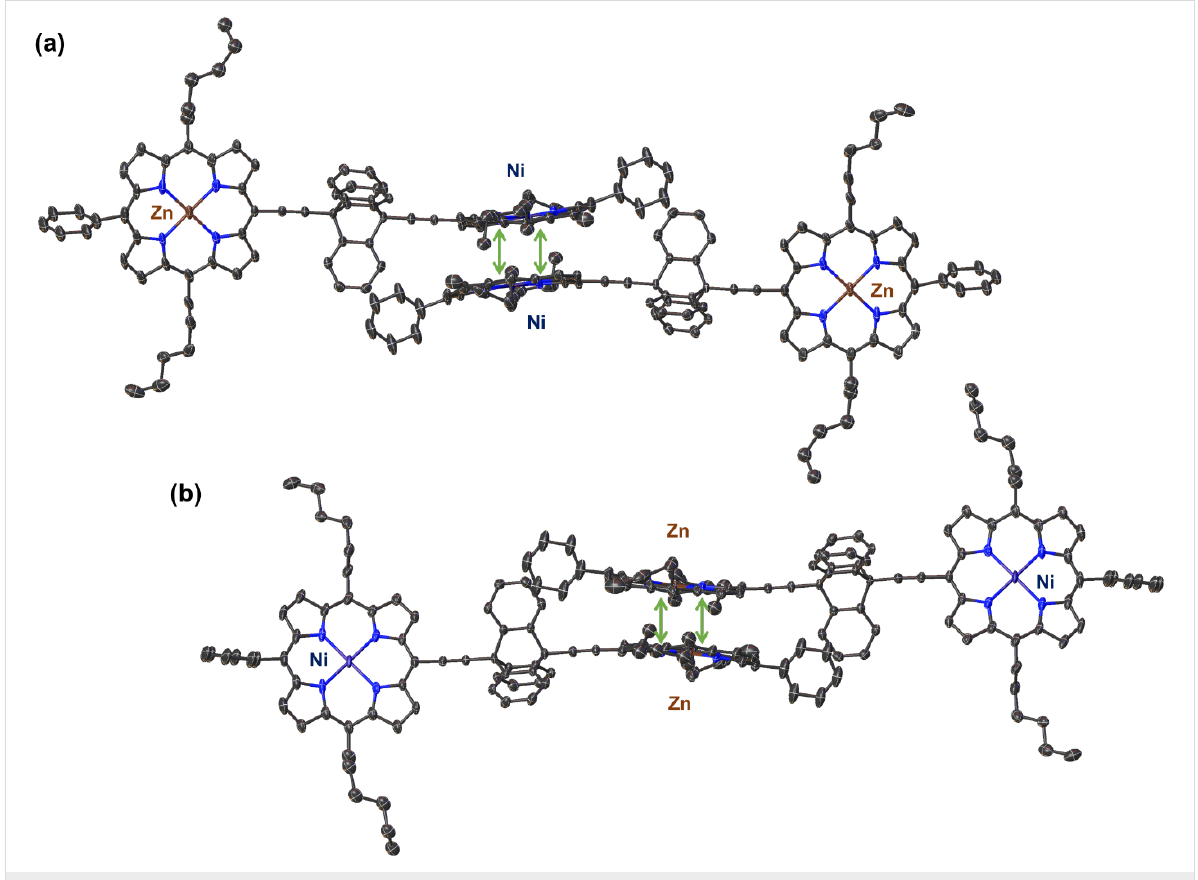
Figure 4: Views of the single crystal X-ray structure of triptycene-linked zinc-nickel porphyrin dimer 16 showing the π -stacking homo-metallic interac- tions between Ni(II)-porphyrin···Ni(II)-porphyrin (a) and Zn(II)-porphyrin···Zn(II)-porphyrin (b). Hydrogen atoms and minor disorder are omitted for clarity (thermal displacement 50%).